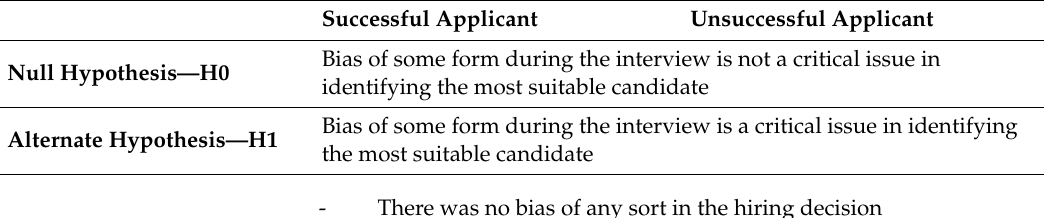
Table 9. Applicant Perspective Hypothesis 7—Bias in some form during the interview.